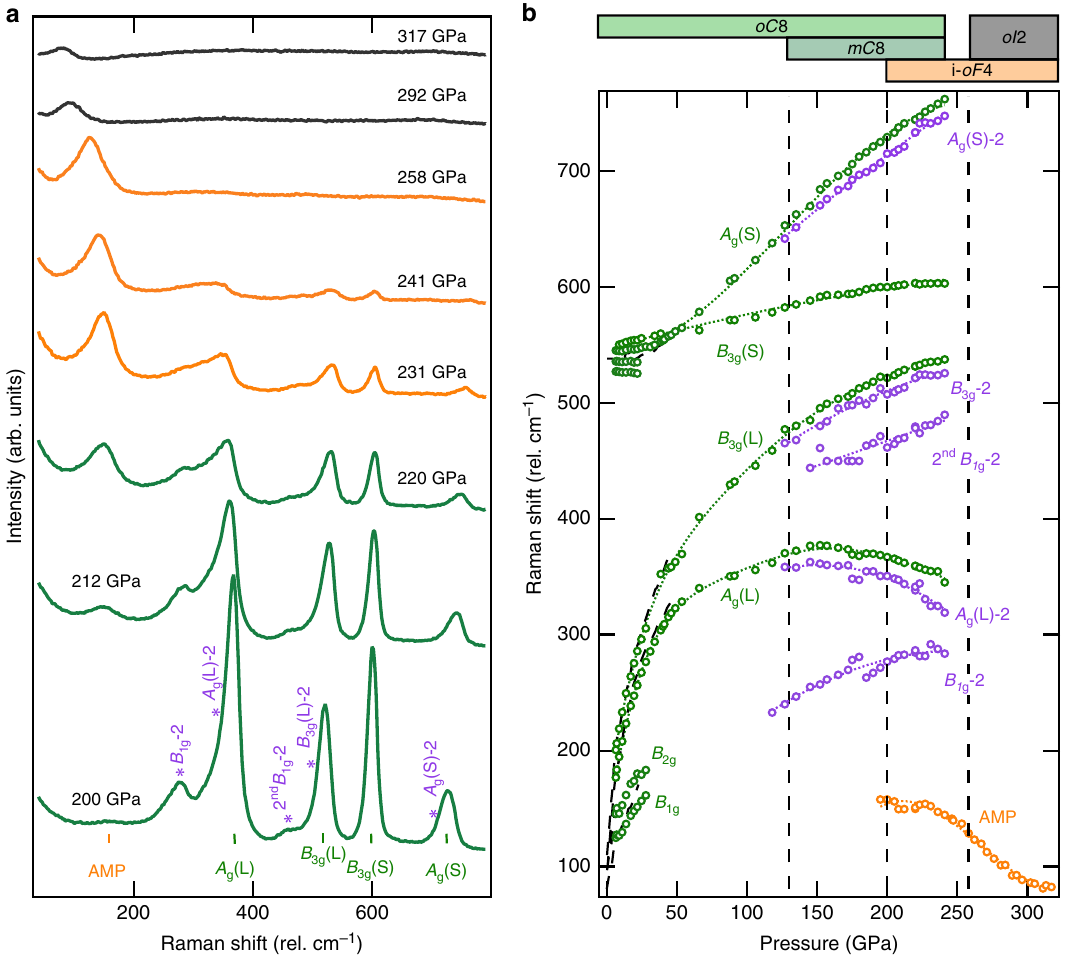
Fig. 2 Raman measurements above 200 GPa. a Raman spectra collected of solid chlorine up to 317 GPa. Excitations corresponding to oC 8 (green markers: B B A mC 8 (purple markers: B A B A A g (L), 3g (L), 3g (S), g (S)), 1g (L)-2, g (L)-2, 3g (L)-2, g (S)-2) and the amplitude mode (orange markers: AMP) of the are denoted below the lowest pressure spectra. b Frequencies of excitations present in solid chlorine as a function of pressure, black dashed curves are from ref. 20 . The vertical dashed lines denote phase transitions, with the corresponding 1-D phase diagram provided atop of the fi gure describing the evolution and coexistance found in chlorine ’ s phase behaviour. The abundance of each phase in coexistance can be qualitatively approximated from the intensities of their excitations, seen here in panel a and quanti fi ed in Supplementary Figure